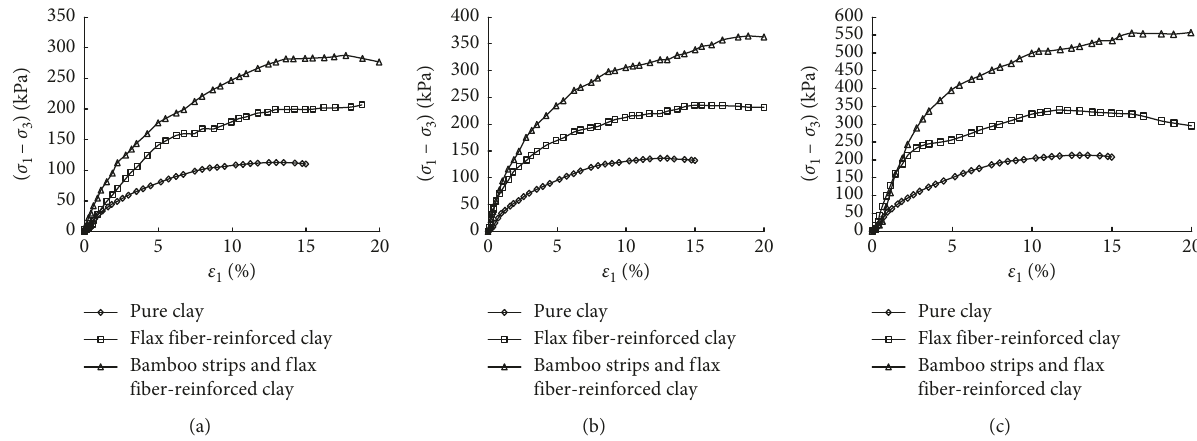
Figure 6: Relationship between the deviator stress and axial strain of pure clay, flax fiber-reinforced clay (FRC), and bamboo strips and flax fiber-reinforced clay (BFRC). (a) 100kPa. (b) 200kPa. (c) 300kPa.